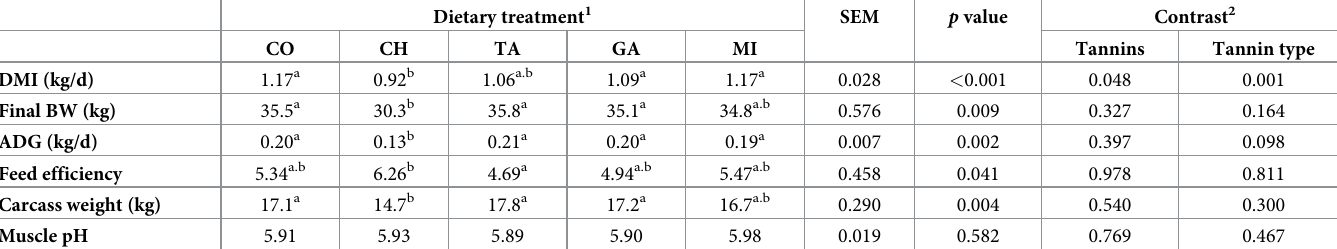
Table 2. Effect of the different tannin extracts on feed intake, lamb performances and carcass characteristics. Dietary treatment 1 SEM p value Contrast